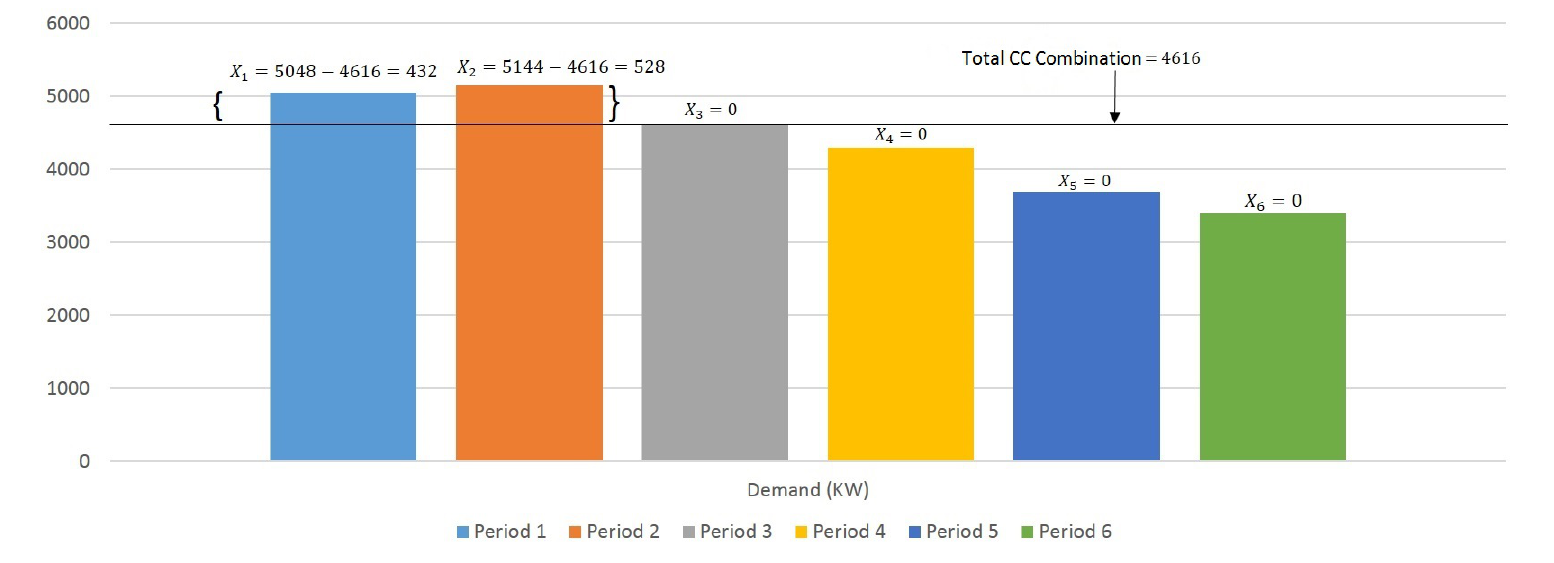
Figure 2. Illustration of excess demand (own